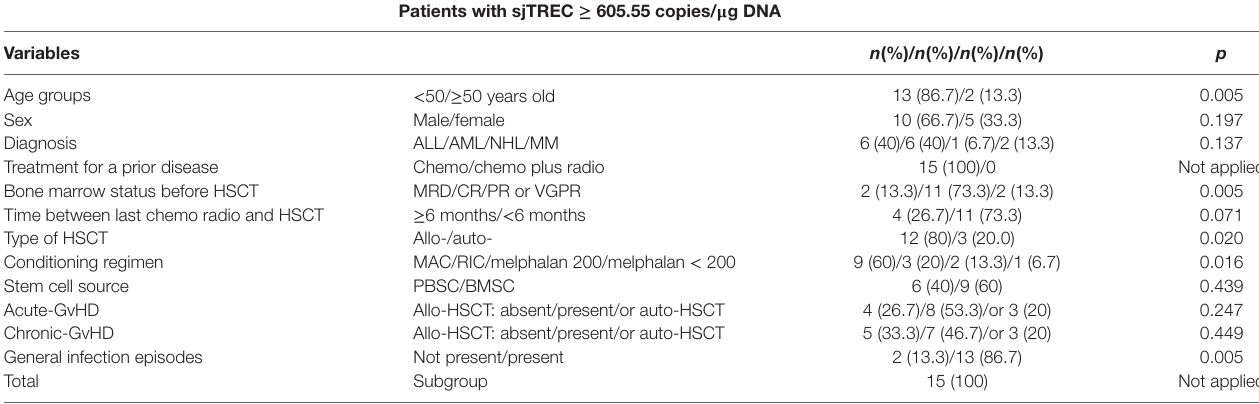
Table 8 | Characteristics of patients after the ninth month post-HSCT with sjTREC copies/ μ g DNA higher than the median of sjTREC value observed for healthy individuals (605.55 sjTREC copies/ μ g DNA).